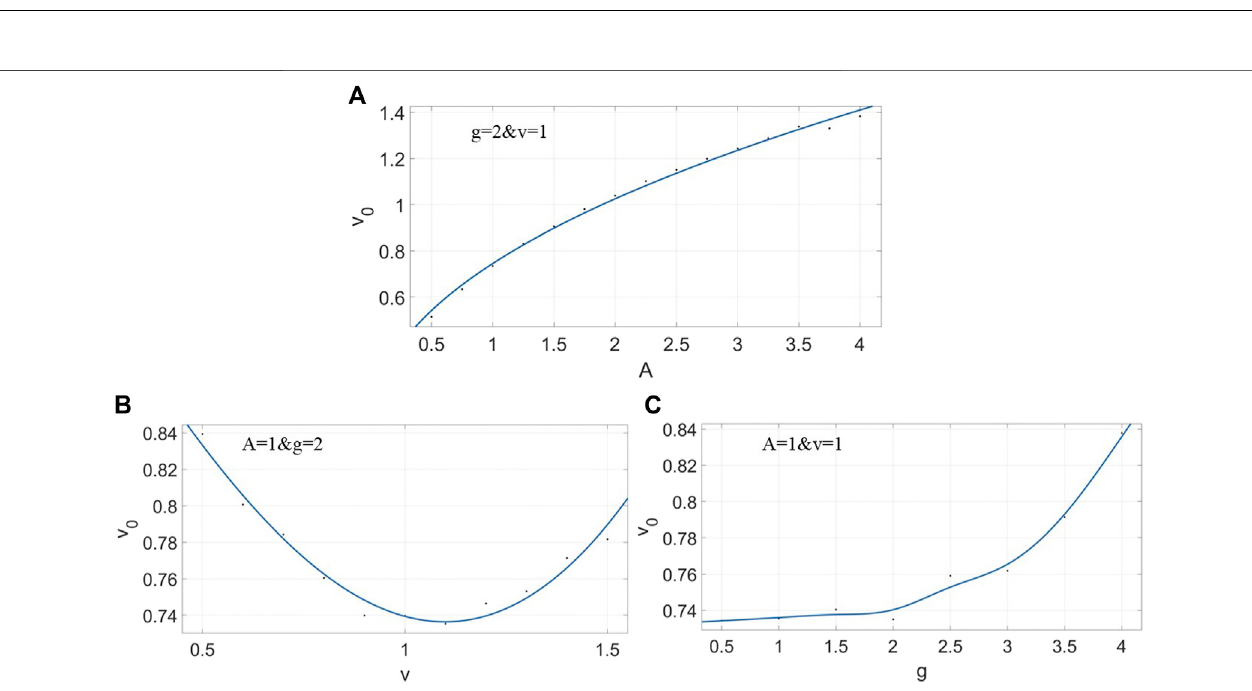
FIGURE 4 | Fitting relations of soliton velocity with the system parameters. (A) Soliton velocity versus the obstacle height. (B) Soliton velocity versus the obstacle speed. (C) Soliton velocity versus the nonlinear strength.